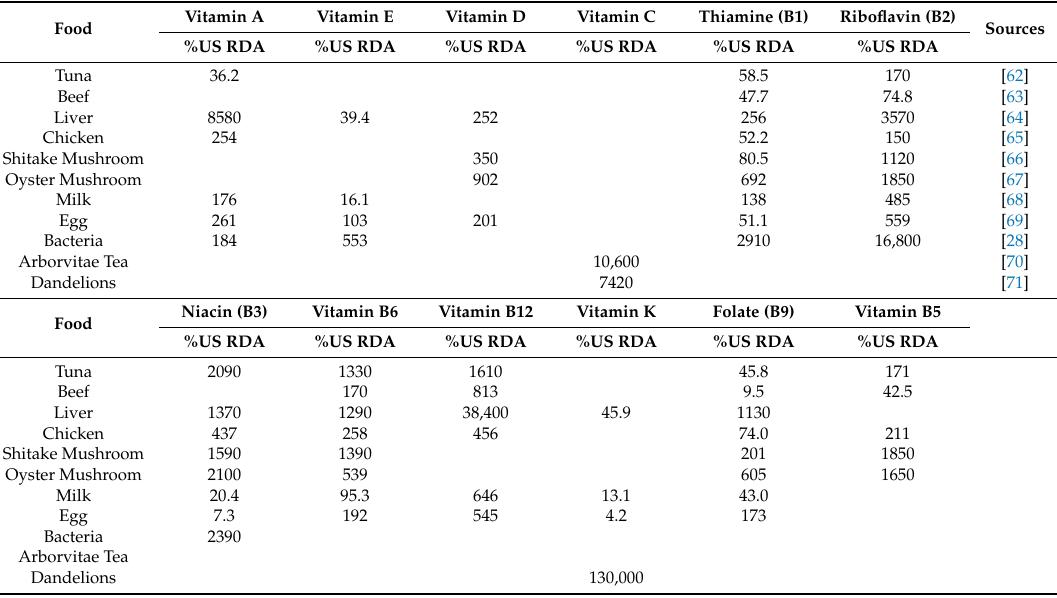
Table A1. Nutrition of 2100 kcal of each selected alternative food analog.